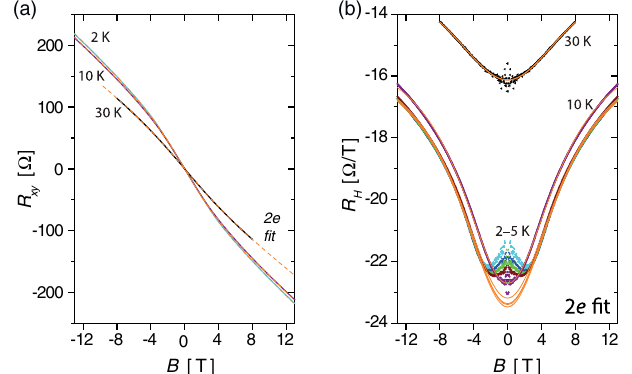
FIG. 3. Hall characteristics obtained for the sample grown at 1 × 10 − 4 mbar in the low-temperature regime for external p dep ¼ fields up to (cid:3) 13 T. (a) R xy obtained from experiment including data fits according to the two-electron model ( 2 e , dashed lines) for T ¼ 2 , 10, and 30 K. (b) Hall coefficient R H ¼ R xy =B obtained from the data in (a) for T ¼ 2 , 3, 4, 5, 10, and 30 K.